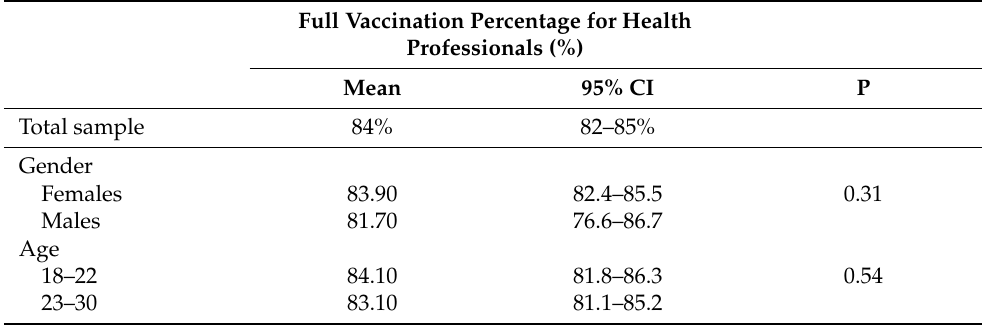
Table 5. Full vaccination coverage for health professionals (%) in total sample and by their